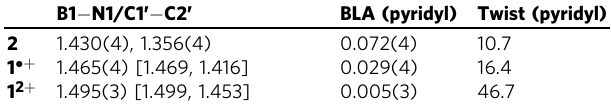
Table 1 Mean distances (Å) and angles (°) between BN- and CC-containing fragments (DFT-calculated exocyclic bond lengths given in square parentheses).